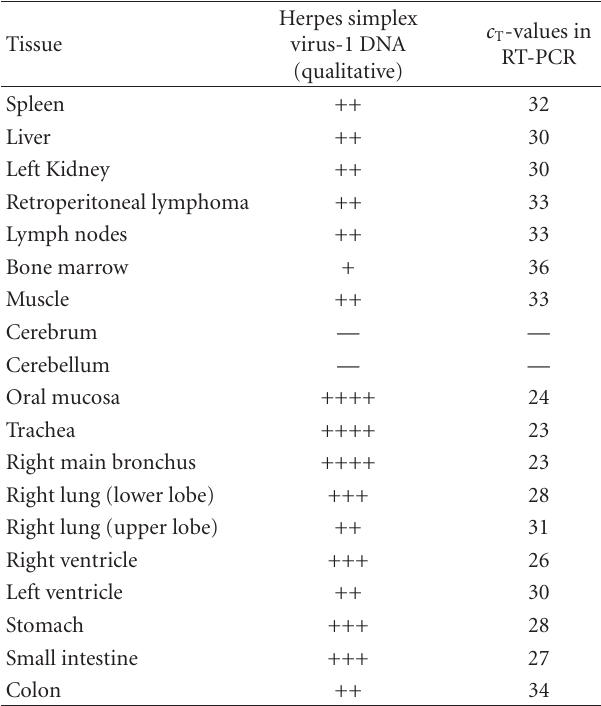
Table 2: Postmortem detection of HSV-1 DNA in various tissues. Results of the semiquantitative PCR performed after mortem detecting virus DNA in all tested tissues except for cerebrum and cerebellum ( c T -value: cycle